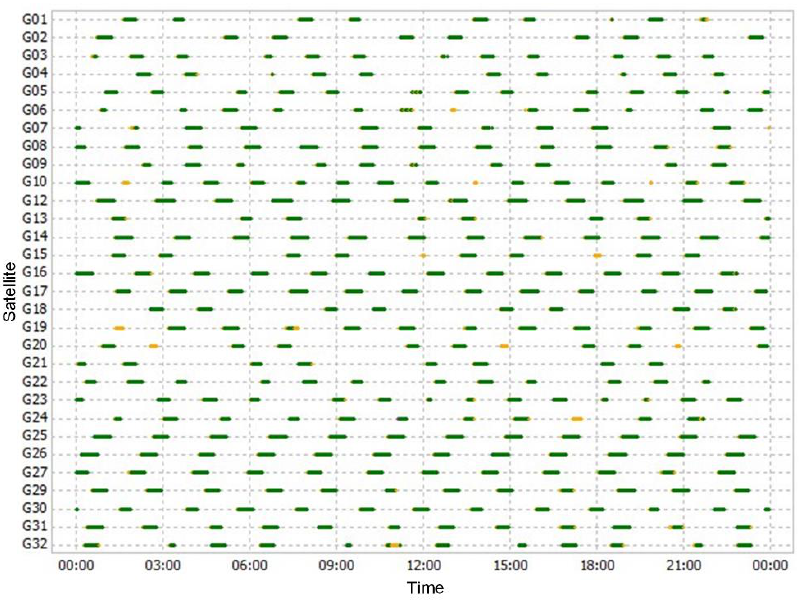
Figure 5. DOY 266 GPS Satellite distribution overview.